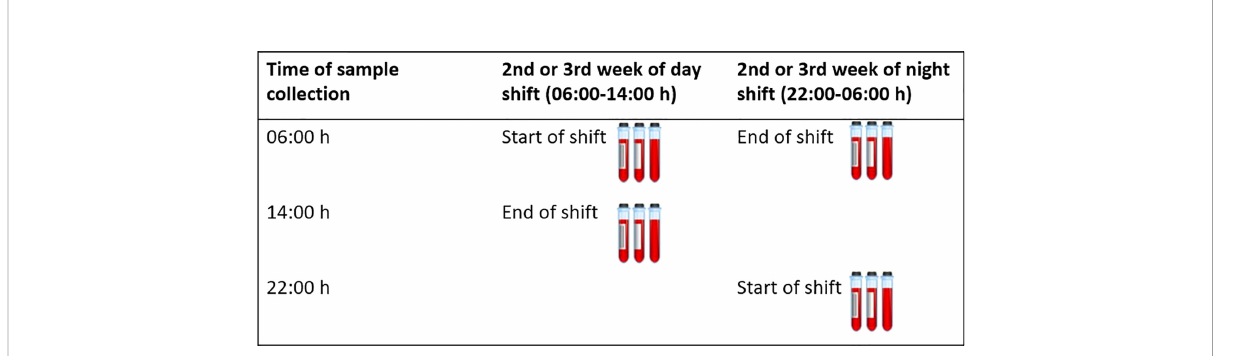
FIGURE 1 Timing of blood collection. This fi gure shows when blood samples were collected for each participant. A total of 4 samples were collected. Two samples were collected on a day shift during the 2 nd or 3 rd week of the rotation (one sample at the start and one at the end of the shift) and two samples were collected on a night shift during the 2 nd or 3 rd week of the rotation (one sample at the start and one at the end of the